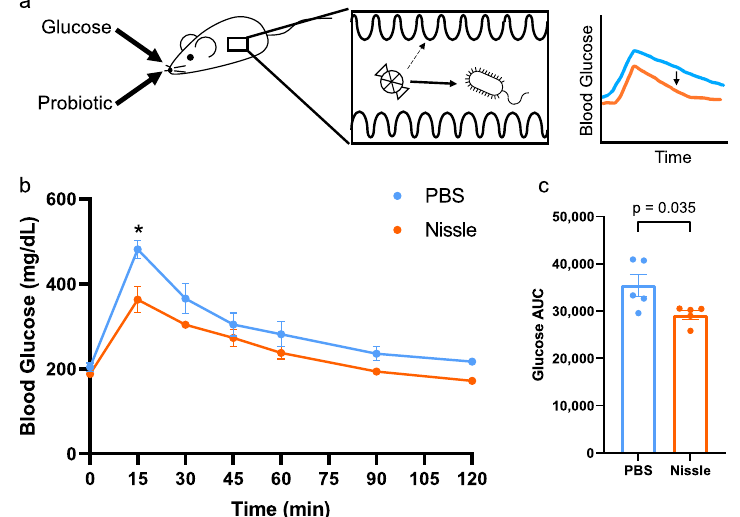
Figure 1. E. coli Nissle 1917 improves glycemic response in healthy mice. ( a ) Experimental design. ( b ) Oral glucose tolerance test (OGTT) showing blood glucose over time following oral glucose gavage. Points represent mean and bars represent SEM (n = 5). ( c ) Area under the curve (AUC, in mg/dL * s) of b (n = 5). Points represent individual mice and bars represent mean and SEM. p values calculated in ( b ) using repeated measures ANOVA with Tukey’s post-hoc test, and in ( c ) using student’s